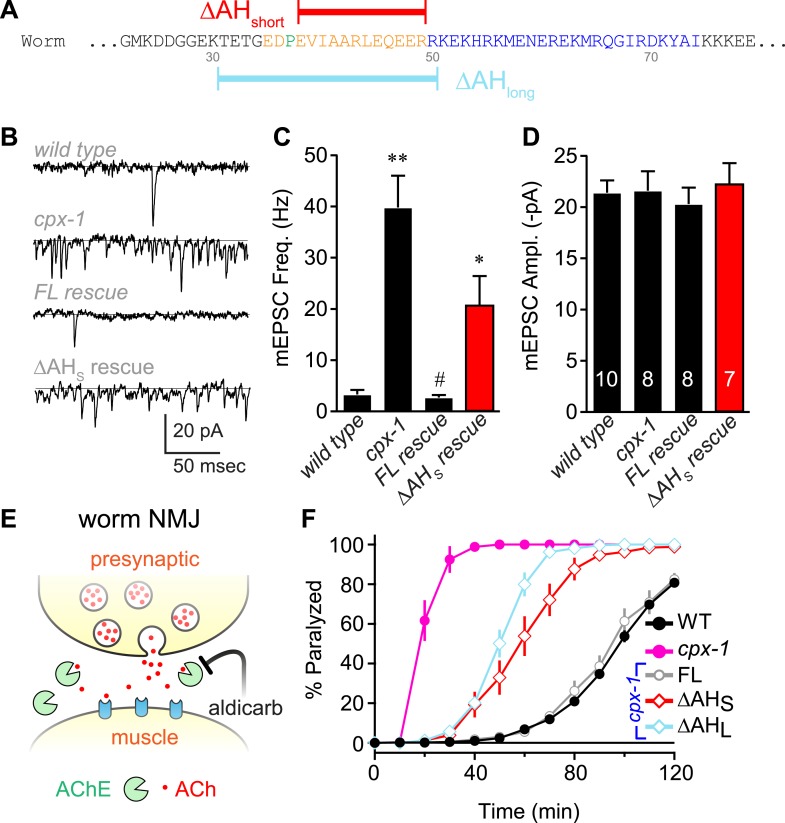
The worm AH contributes to CPX-1 inhibition of spontaneous vesicle fusion.(A) Two deletions within the worm AH domain were used: ΔAHshort (35–49, red) and ΔAHlong (30–50, aqua). (B) Examples of spontaneous EPSCs in zero external Ca2+ for wild-type, cpx-1, and transgenic animals expressing full-length CPX-1 (FL rescue) and the short AH deletion (ΔAHshort
rescue). Average spontaneous EPSC Rate (C) and EPSC amplitude (D) for the genotypes indicated in B. Data are mean ± SEM and the number of independent assays is indicated for each genotype. Using Tukey–Kramer statistics for multiple comparisons, ** denotes significantly different from wild type, # significantly different from cpx-1 but not wild type, * significantly different from both wild type and cpx-1 (p < 0.01). (E) Cartoon of aldicarb acting at the worm cholinergic neuromuscular junction. Acetylcholine (ACh, red) is hydrolyzed by cleft cholinesterases (AChE, green). Aldicarb inhibits AChE causing an elevation in ACh and eventual paralysis depending on the level of exocytosis. (F) Paralysis time course on 1 mM aldicarb for wild-type (black filled circles, n = 36), cpx-1 (pink filled circles, n = 10), full-length rescue CPX-GFP (gray open circles, n = 10), ΔAHshort rescue (red open diamonds, n = 10), and ΔAHlong rescue (aqua open diamonds, n = 10).